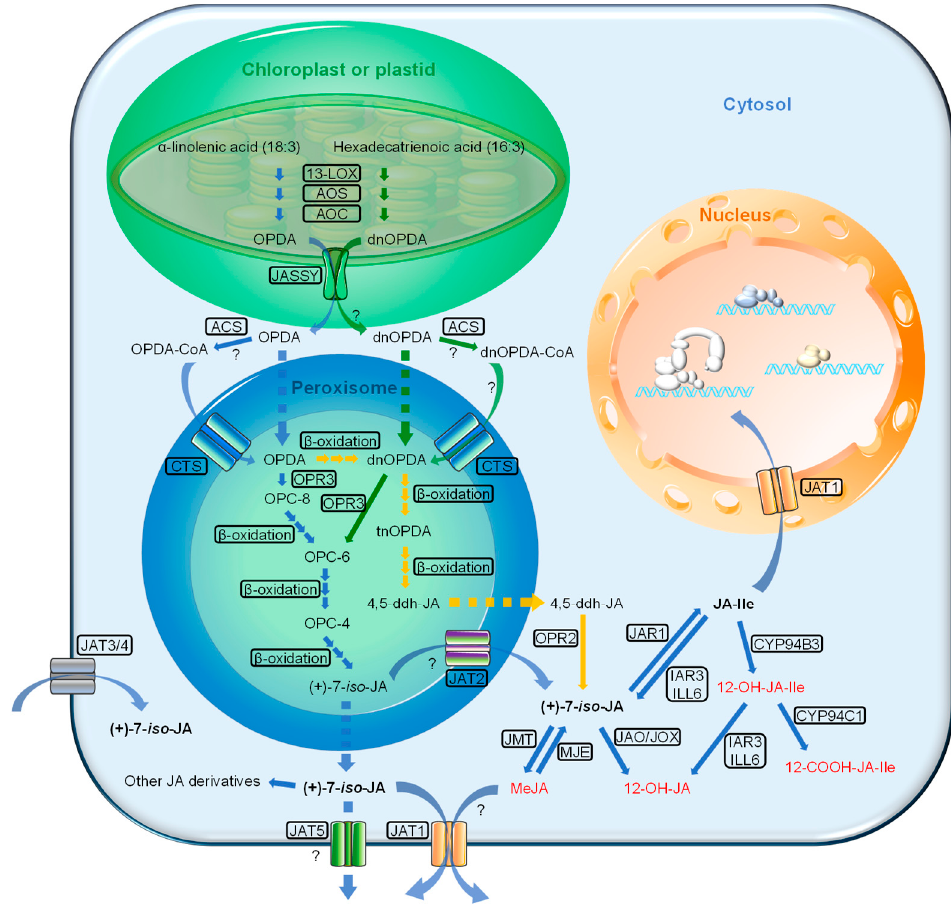
Figure 1. Simplified JA (jasmonic acid) biosynthetic and metabolic pathways and intracellular flux in Arabidopsis. The blue arrows represent the octadecane pathway, the green arrows represent the parallel hexadecane pathway, and the yellow arrows represent the OPR3-independent pathway. Biologically inactive JA derivatives are shown in red. Biosynthetic and metabolic enzymes, as well as transporters are boxed. 13-LOX, 13-lipoxygenase; AOS, allene oxide synthase; AOC, allene oxide cyclase; OPR, OPDA reductase; ACS, acyl-CoA synthetases; JAR1, JA-amido synthetase; IAR3 and ILL6, two JA amidohydrolases; JMT, JA methyl transferase; MJE, MeJA esterase; JAO, JA oxidase; JOX, jasmonate induced oxidase; CYP94B3, JA-Ile-12-hydroxylase; CYP94C1, 12-OH-JA-Ile carboxylase; JASSY, OPDA transporter; CTS, ABC transporter COMATOSE; JAT, jasmonate transporter. dnOPDA, dinor-oxo-phytodienoic acid; tnOPDA, tetranor-OPDA; OPC-8, 8-[3-oxo-2- {pent-2-enyl}cyclopentyl]octanoic acid; OPC-6, 6-[3-oxo-2-{pent-2-enyl}cyclopentyl]hexanoic